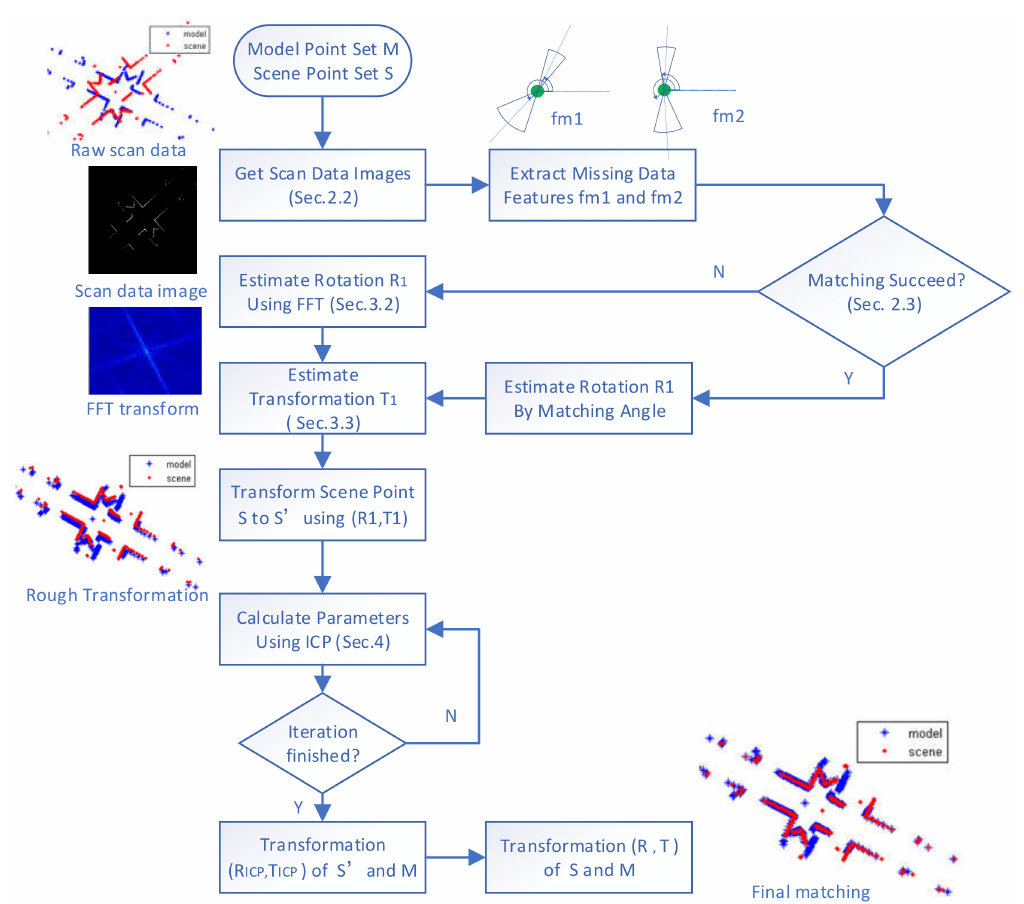
Figure 5. Proposed Fast Fourier Transform-Iterative Closest Point (FFT-ICP) scan-matching frame-work.